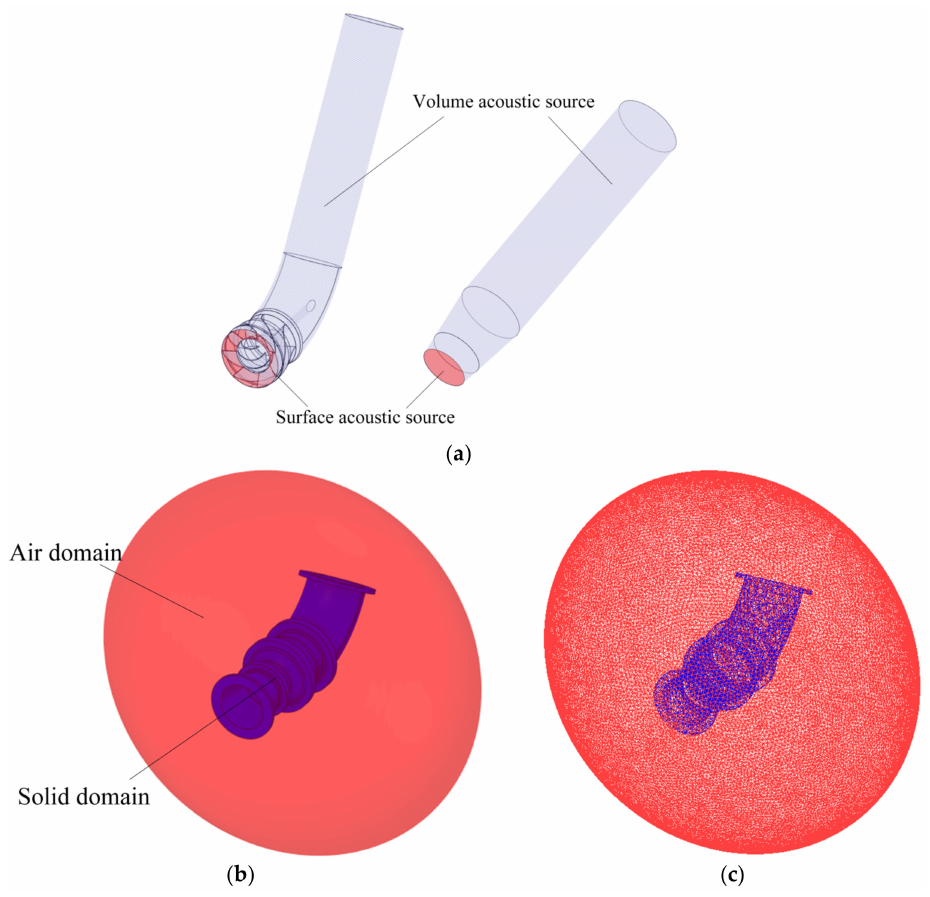
Figure 6. Acoustic calculation settings: ( a ) Flow noise calculation domain and sound source; ( b ) Radiation noise calculation domain; ( c ) Mesh of radiation noise calculation